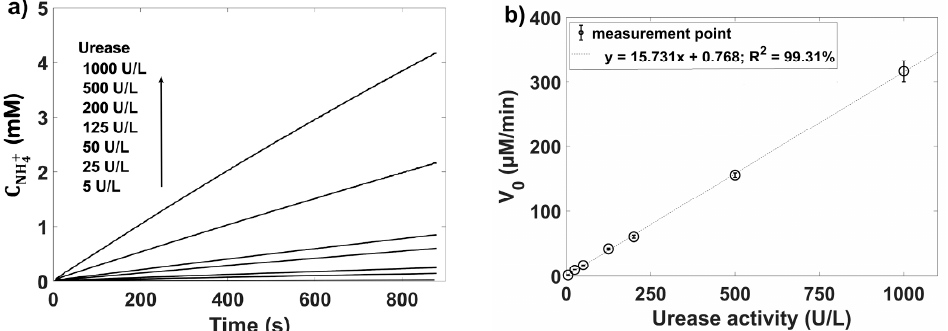
Figure 5. ( a ) Kinetics of urea decomposition reaction at constant initial urea concentration for given urease activity (5–1000 U/L) and ( b ) corresponding calibration curve plotted as dependence between initial enzymatic reaction rate ( V 0 ) and urease activity.